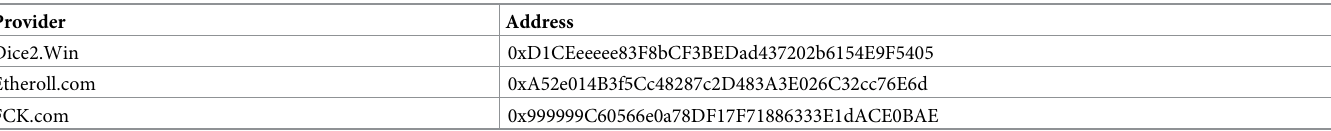
Table 1. Smart contract addresses for each decentralised gambling application used in this study.